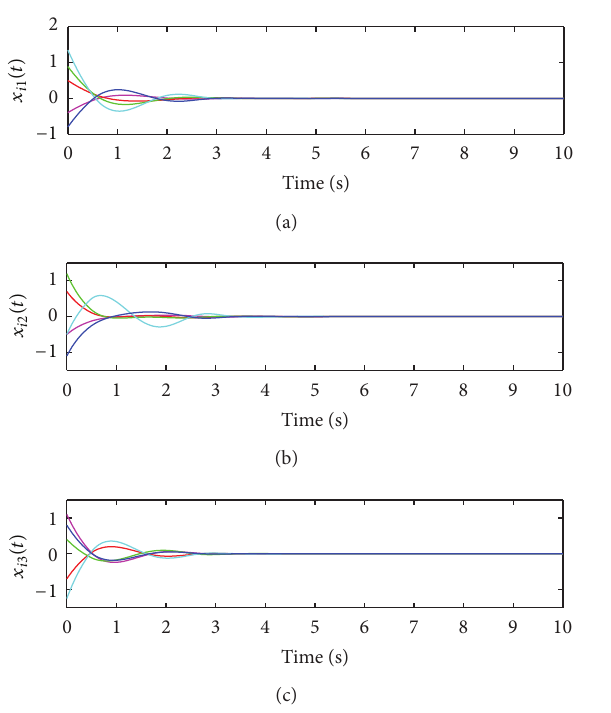
Figure 4: Synchronization state curves for the nonsynchronizable subnetwork